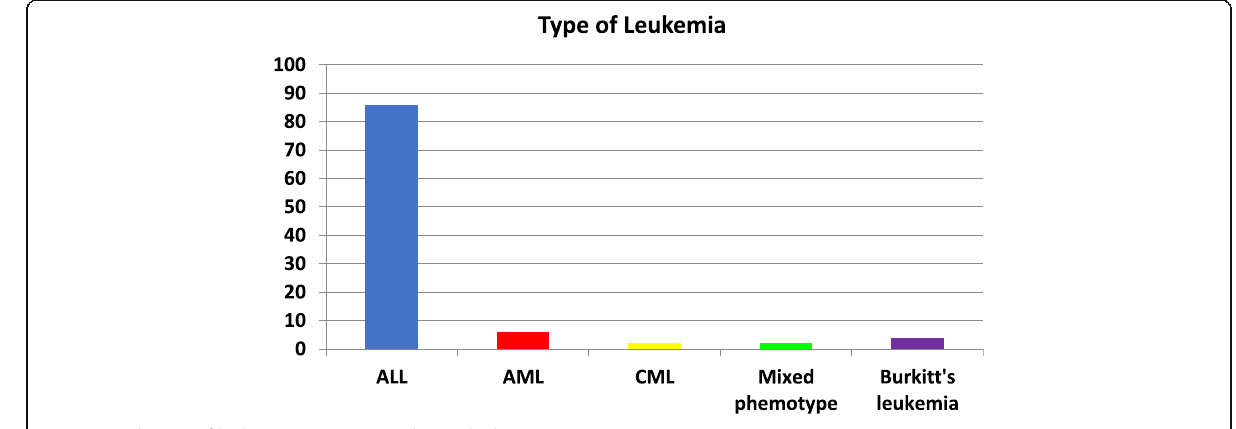
Fig. 1 Distribution of leukemia types among the studied group